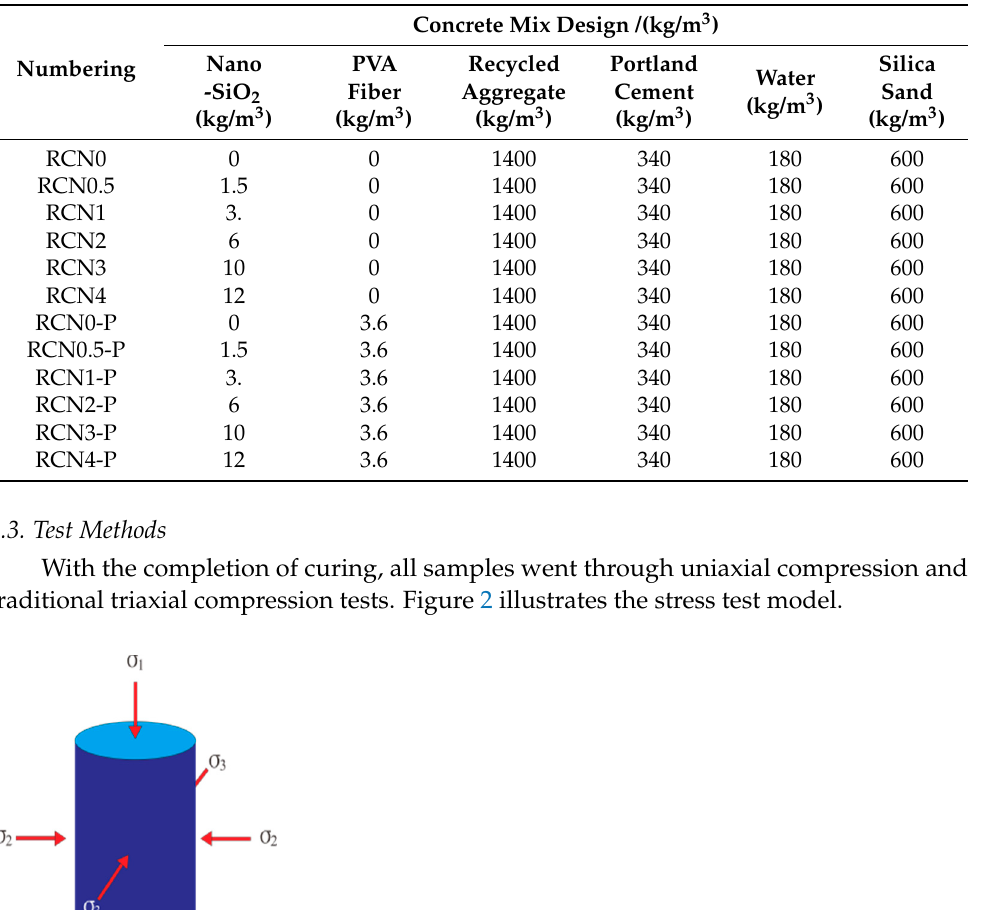
Table 2. Proportion of sample.